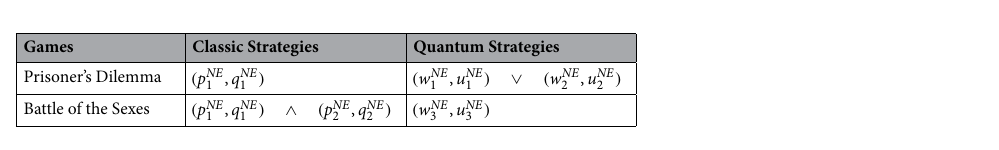
Table 1. Nash equilibria in terms of joint probabilities.